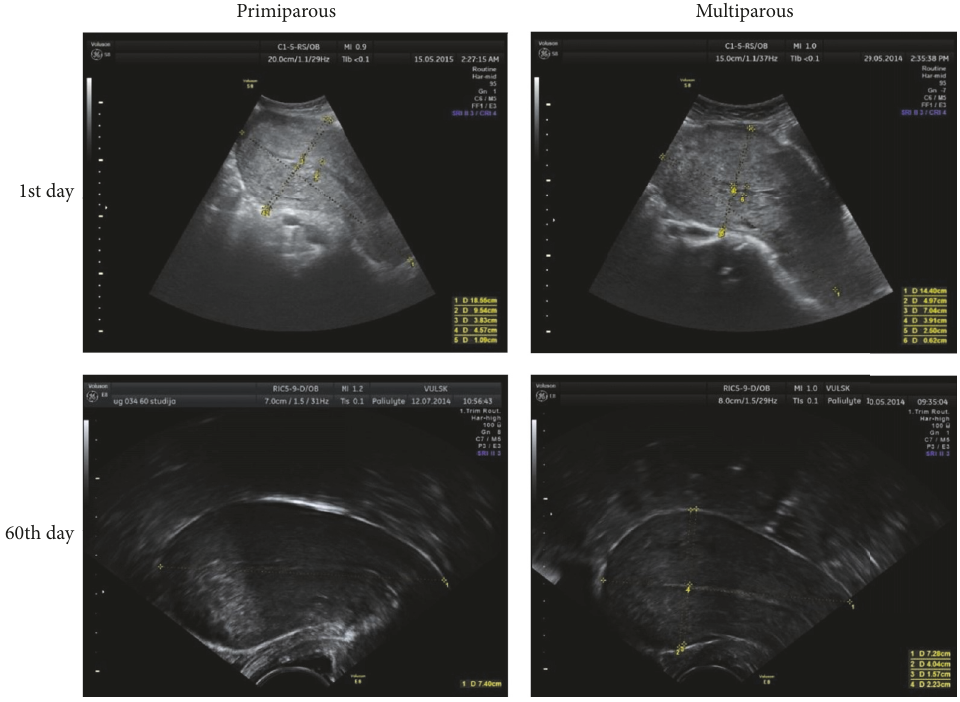
Figure 1: Uterus length measurements in longitudinal